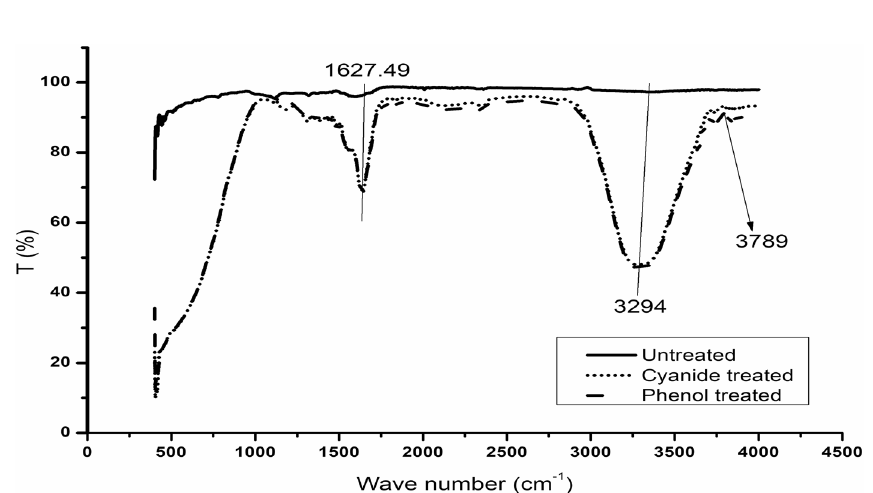
Fig. 5 FTIR graph of